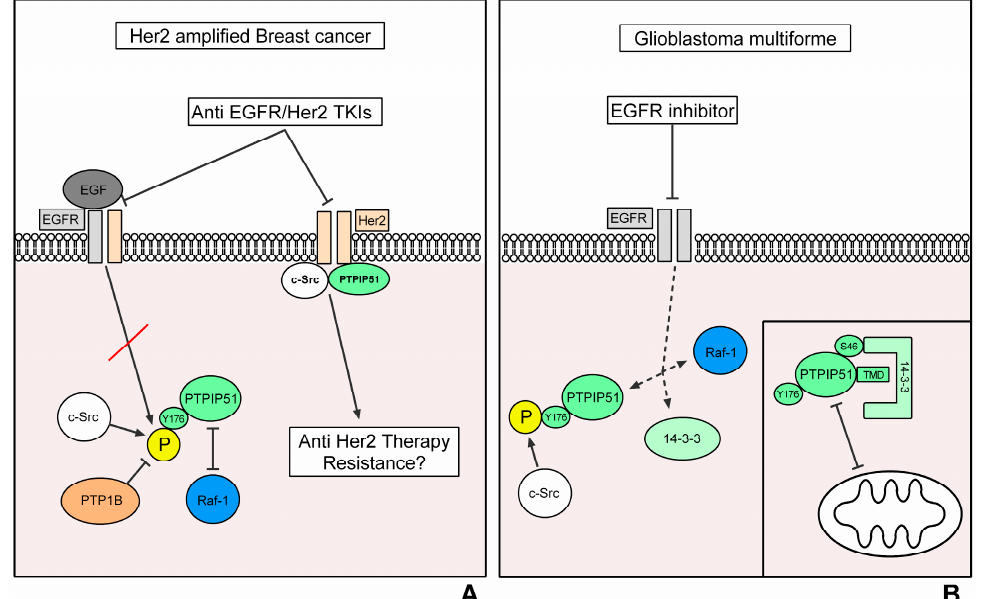
Figure 2. Regulation of PTPIP51 interactions in breast cancer. The inhibition of EGFR in Her2 amplified breast cancer cells induces the same effects as observed in the HaCat cell line upon EGFR inhibition regarding the formation of the Raf-1/14-3-3 β /PTPIP51 complex. The sensitivity of Her2 amplified breast cancer cells towards EGFR-targeted TKIs correlates with the regulation of the interaction of PTPIP51 with c-Src. The selective inhibition of Her2 induces a formation of a PTPIP51/Her2/c-Src complex, which depicts a potential resistance mechanism against anti-Her2 therapies (black arrows indicate a phosphorylation/activation, arrows with vertical bar as arrow head indicate an inhibition of interaction/activation) ( A ); regulation of PTPIP51 interactions in Glioblastoma multiforme. The left side of the figures depicts the regulation of PTPIP51 interactome under EGFR inhibition. Contrary to the expectations, the inhibition of the EGFR induces a disruption of the Raf-1/14-3-3 β /PTPIP51 complex. The right side of the figure shows that the upregulated 14-3-3 protein levels in gliomas of high malignancy potentially inhibit the translocation of PTPIP51 to the mitochondrion and thus its apoptosis-inducing effects (black arrows indicate a phosphorylation/activation, arrows with vertical bar as arrow head indicate an inhibition of interaction/activation, dotted black arrows indicate a dissolution of the Raf-1/14-3-3 β /PTPIP51 complex via EGFR inhibition) ( B